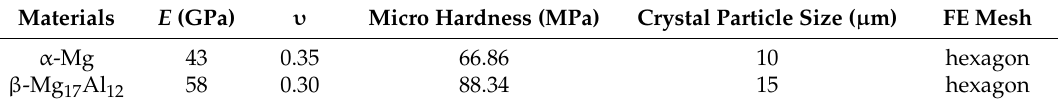
Table 2. Mechanical properties of micro structure for AM60B alloy.